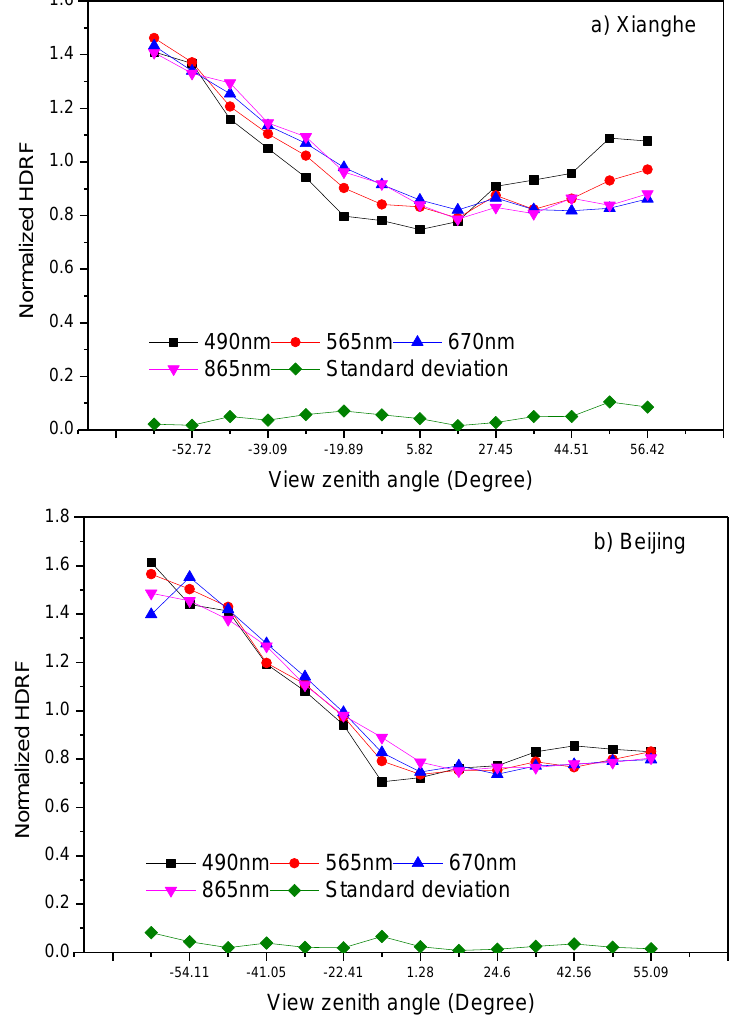
Figure 1. Normalized HDRFs and the corresponding standard deviation calculated from PARASOL intensity on 26 October 2009 over ( a ) Xianghe and ( b )